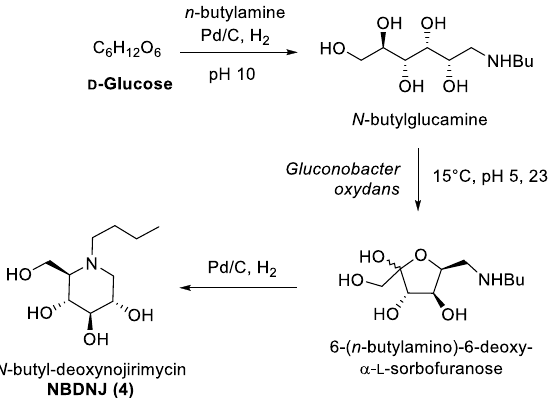
Scheme 1. Chemo-enzymatic synthesis of NBDNJ (reproduced with permission from [1]).